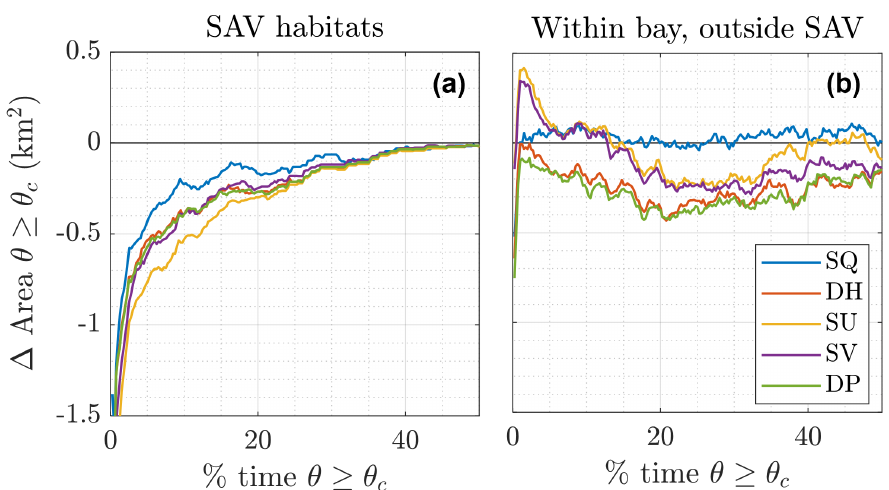
Figure 5. Change in total area where erosion threshold exceeded due to the inclusion of SAV via the tested SAV treatment as compared to control; x -axis corresponds to frequency of threshold exceedance (percent of 40-day simulation). Total within-bay area examined separately as area ( a ) outside SAV patches and ( b ) within SAV patches.